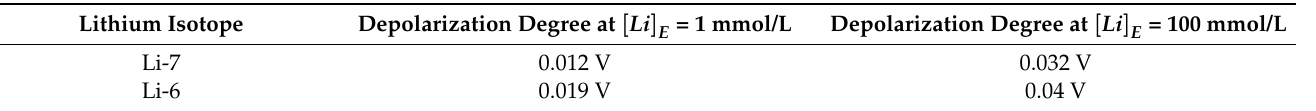
Table 27. The table shows the depolarization degree based on the quantum transport of both isotopes as in graph (a) of Figure 10. Lithium